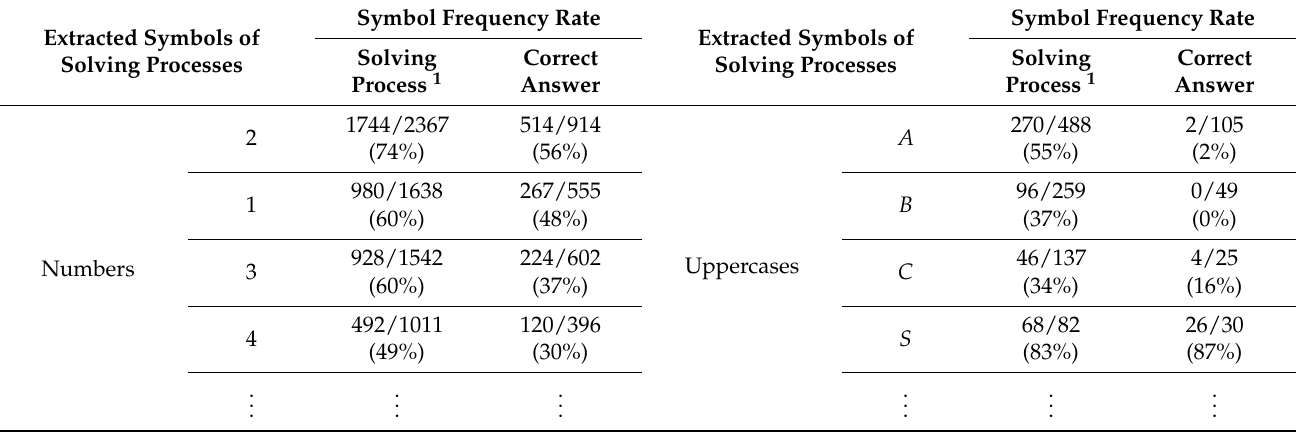
Table A5. Sample Frequency Rates in Different Solving Processes and Correct Answers for Symbols Extracted from Such